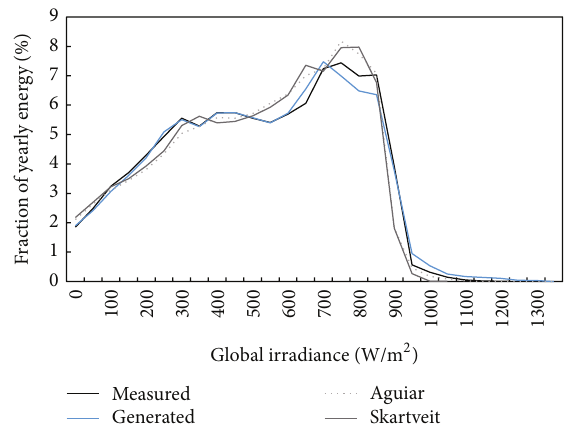
Figure 9: Frequency distributions of measured global irradiance for Carpentras (France, 2001) against values generated by different algorithms. For locations with higher yearly global irradiation, the high irradiance peak grows. Mid values are slightly overestimated, and high values are underestimated by the existing models (grey dotted), resulting in RMSE of 0.549% for Aguiar and 0.575% for Skartveit. The modelling quality of the new method (blue) does not overestimate mid irradiance values and shows only little underestimation of high irradiance values. The new RMSE can be reduced to 0.237%.